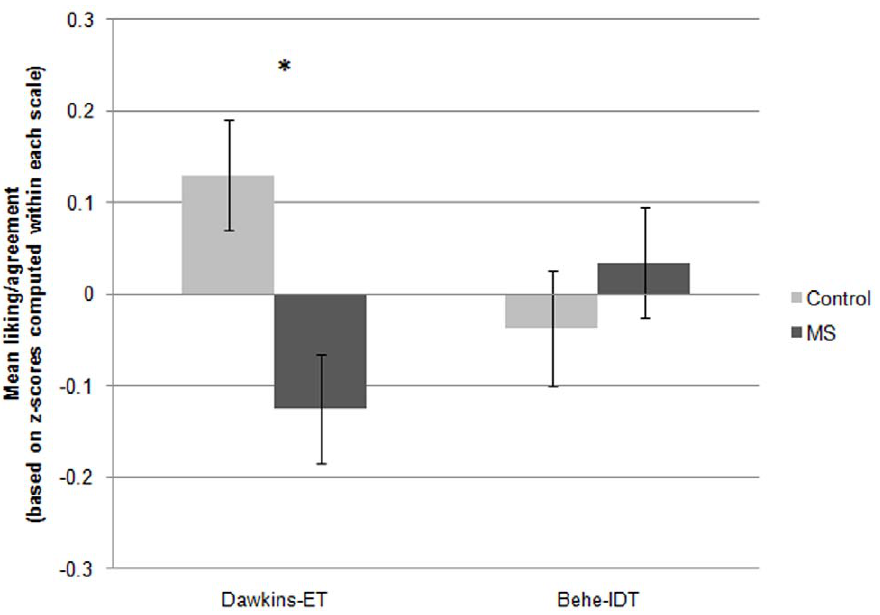
Figure 3. Effects of MS on liking of Behe and belief in IDT, and liking of Dawkins and belief in ET, Study 3. Note. Values are based on standard scores; means for each scale were computed by standardizing each of the six author-theory items that the scale comprised, around their common mean, and taking the mean of the resulting z-scores. Because the two scales were centered around different means, values on the two scales (Dawkins-ET and Behe-IDT) cannot be directly compared to each other. The overall interaction, which emerged from a between-subjects ANOVA, and the difference between the control and MS conditions, based on a t -test on Dawkins-ET, were significant, p , .05. Error bars represent the standard error of the mean. * p , .05.